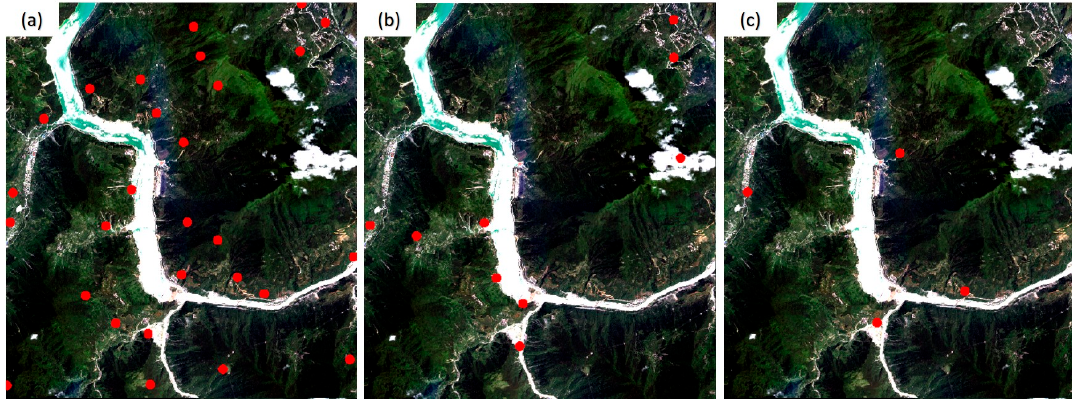
Figure 13. Matched tie points of the GF-1 image. ( a ) The proposed method, ( b ) Patch-SIFT, and ( c ) SIFT.